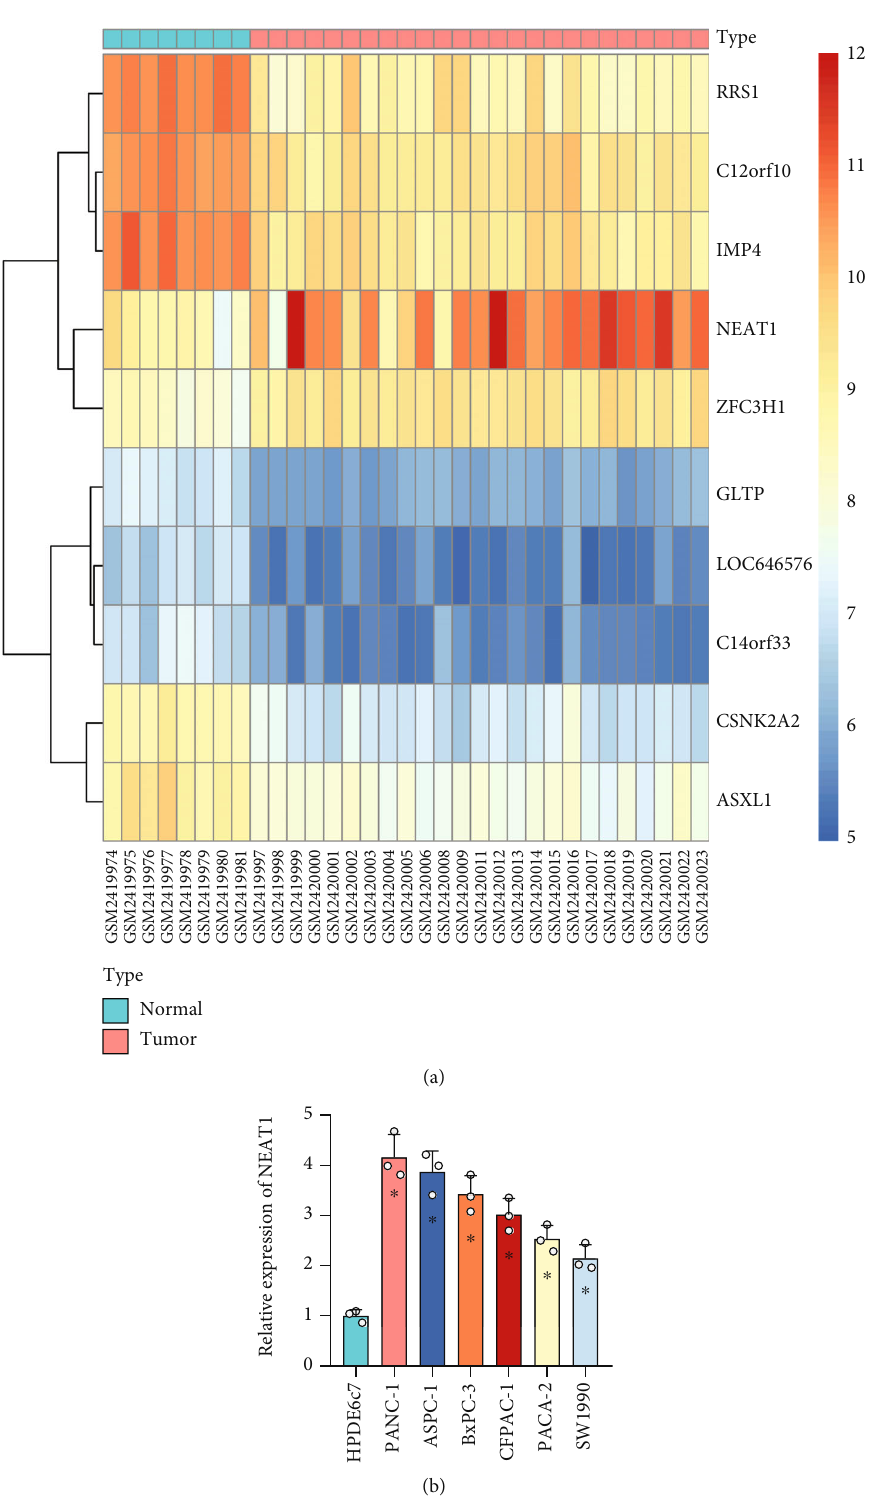
Figure 1: Target genes and cell lines were screened based on bioinformatics analysis and in vitro cell experiments. (a) Unsupervised